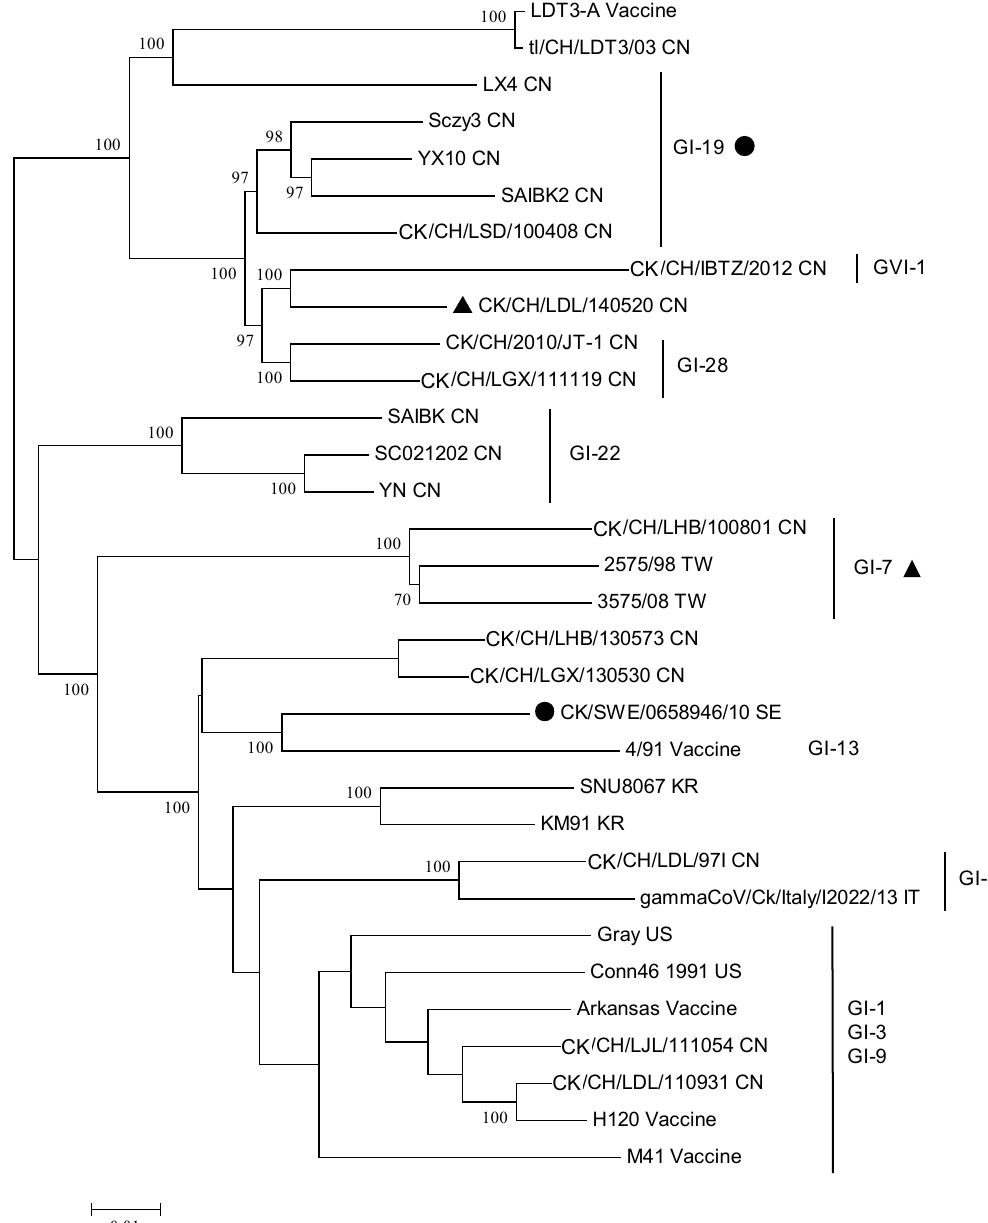
Figure 2. Phylogenetic analysis of the full-length genome of the IBV variants reviewed in this study and reference strains. The strains with a symbol belong to the lineage with the same symbol when the S1 gene is analyzed. The phylogenetic tree was constructed using MEGA version 6 by the neighbor-joining method (bootstrapping for 1000 replicates, bootstrap value >70%). CN: China; IT: Italy; KR: Korea; SE: Sweden; TW: Taiwan; US: United States. Supplementary Materials: Supplementary materials can be found at www.mdpi.com/1422-0067/18/10/2030/s1.